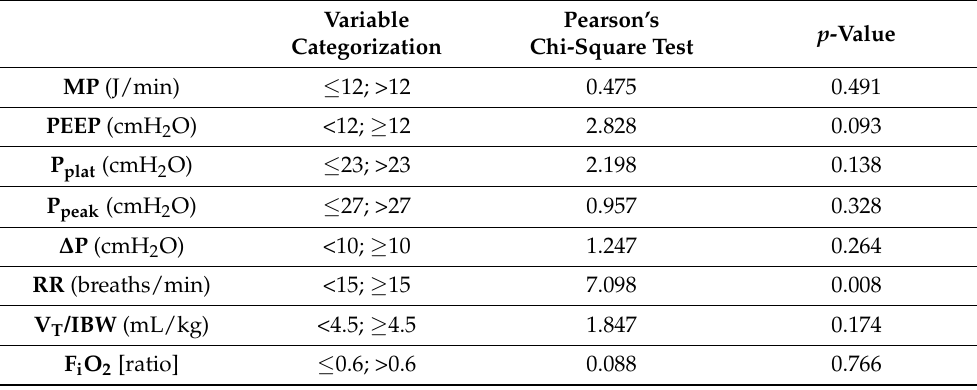
Table 4. Association with ICU mortality, according to the categorization of MV parameters during